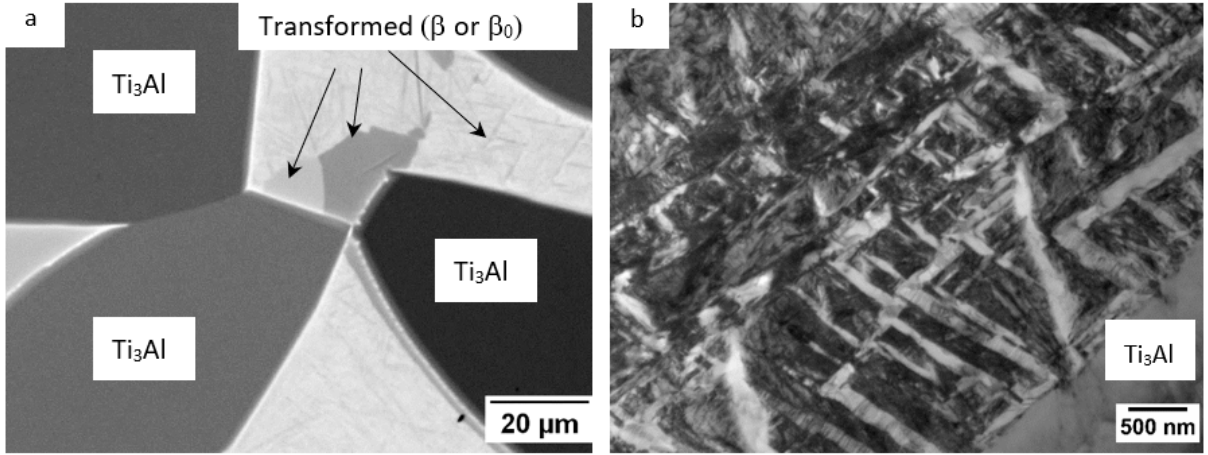
Figure 4. Microstructure of Z1 (Ti-20.6Al-10.1Zr at. %), heat treated at 1000 °C/1000 h: ( a ) SEM back-scattered electron (BSE) micrograph, ( b ) TEM bright field (BF) micrograph.